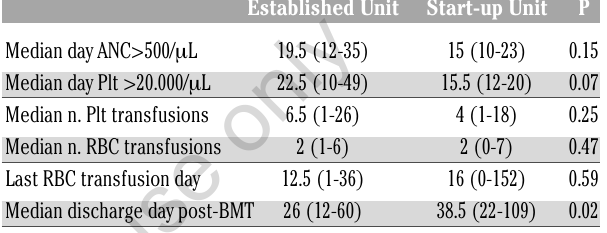
Table 2. Engraftment data.